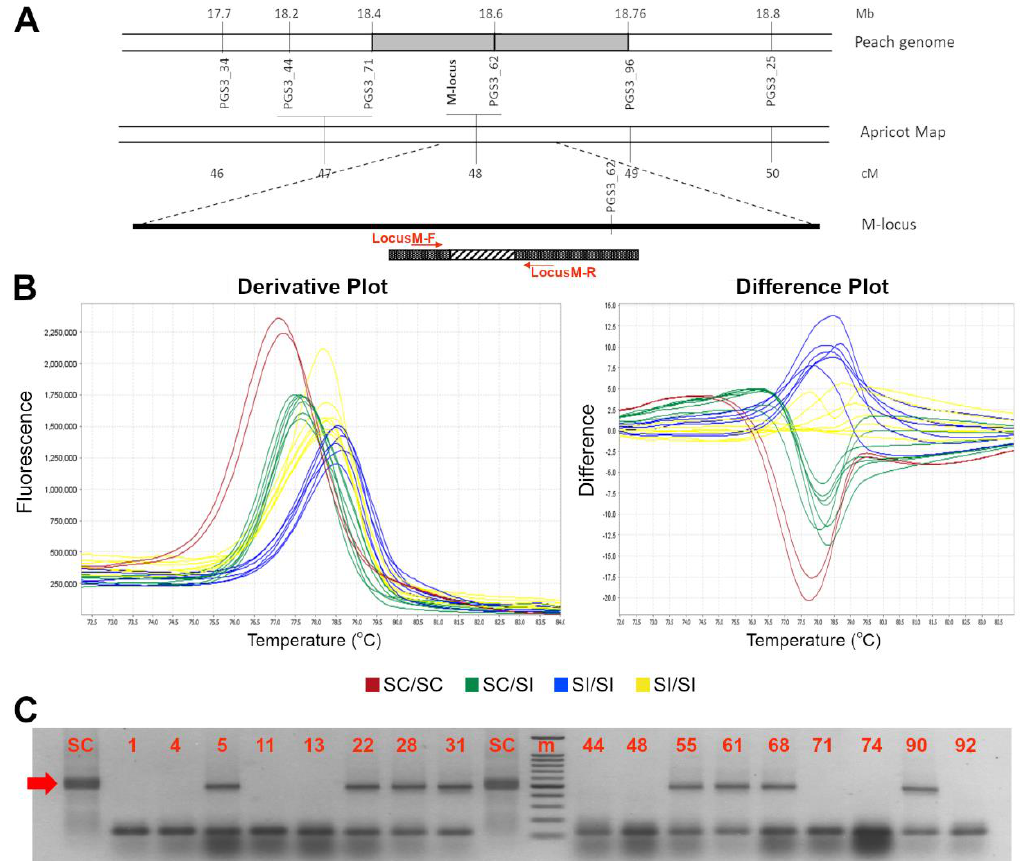
Figure 3. High resolution melting assay for distinction between SI (M), and SC ( m- HOM and m - HET ) genotypes. Schematic representation of the M -locus ( A ). At the bottom, the ParM-7 ( ParMDO gene) with the primer used in this work; the diagonal stripe pattern represents the 358 bp inserted element at position 332 to 690 from the first nucleotide of the ORF. ( B ) Derivative (left) and aligned (right) melting curves of the HRM assays for the M -locus alleles: in red and yellow two possible SI homozygous profiles, in blue the SC m - HOM and in green the m - HET . ( C ) Electrophoresis gel of HRMA product showing SC (indicated by the red arrow) and SI alleles amplicons of ~500 and ~150 bp long, respectively. A 100 bp marker has been used as ladder in the analysis. Accession number is indicated in Table 1.